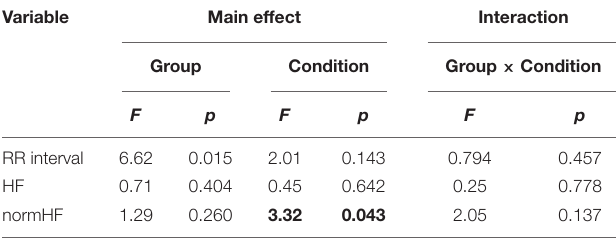
TABLE 4 | Summary of the statistical results in the heart rate variability analyses.